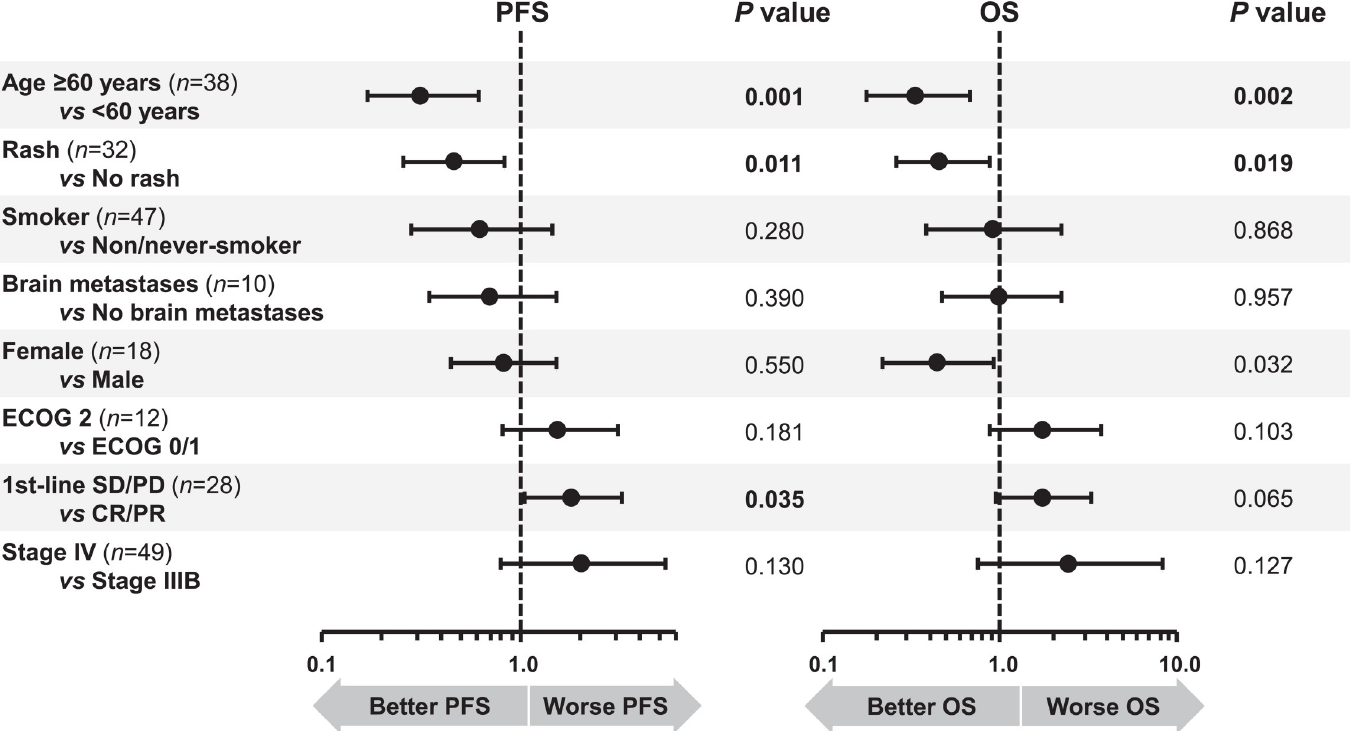
Fig 4. Forest plot of hazard ratios (HR) of baseline predictors of overall survival (OS).